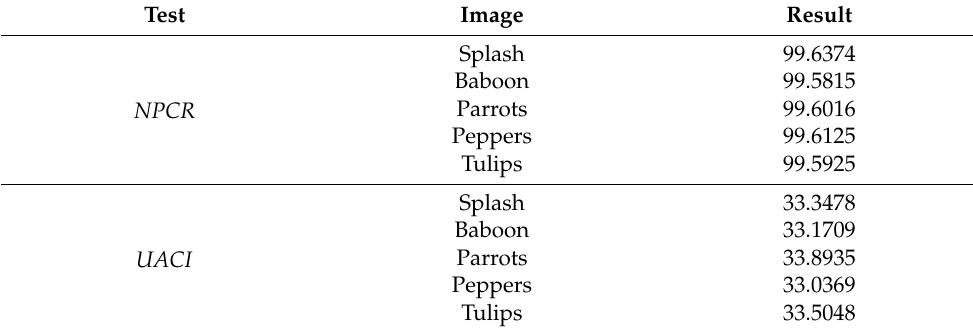
Table 4. NPCR and UACI measures for various standard